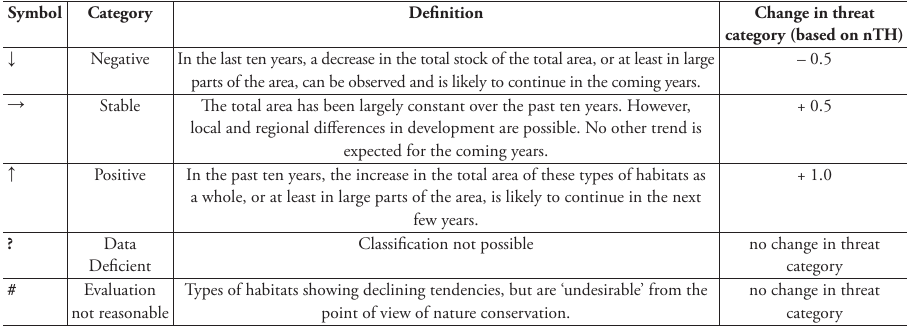
Table 2. Definition of criterion II ‘Current Trend’ (T) and implication for the risk assessment